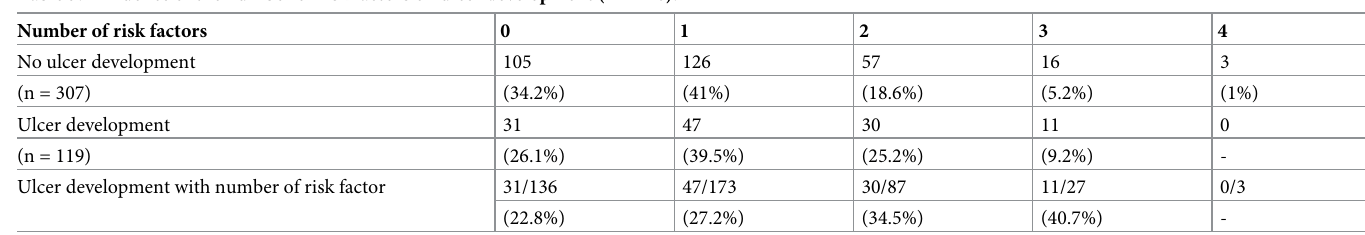
Table 5. Influence of the number of risk factors on ulcer development (n = 426).